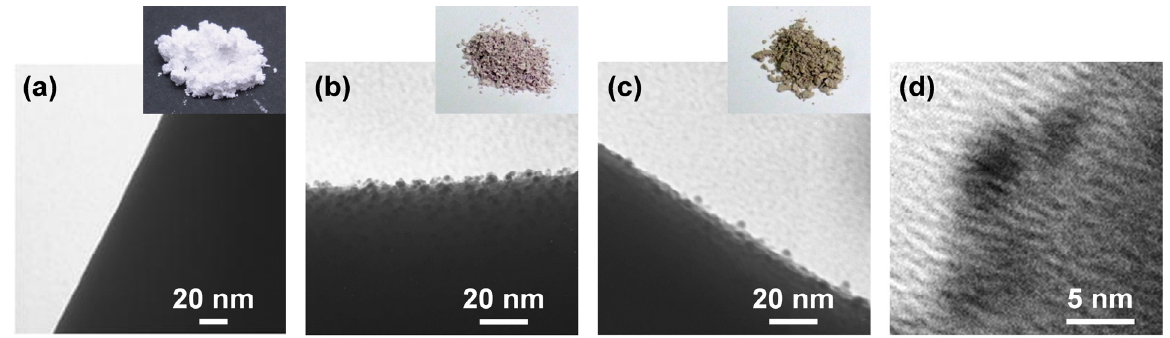
and ( c ) HAuCl and AgNO ; ( d ) High-resolution TEM images of 4 4 3 and AgNO 4 3